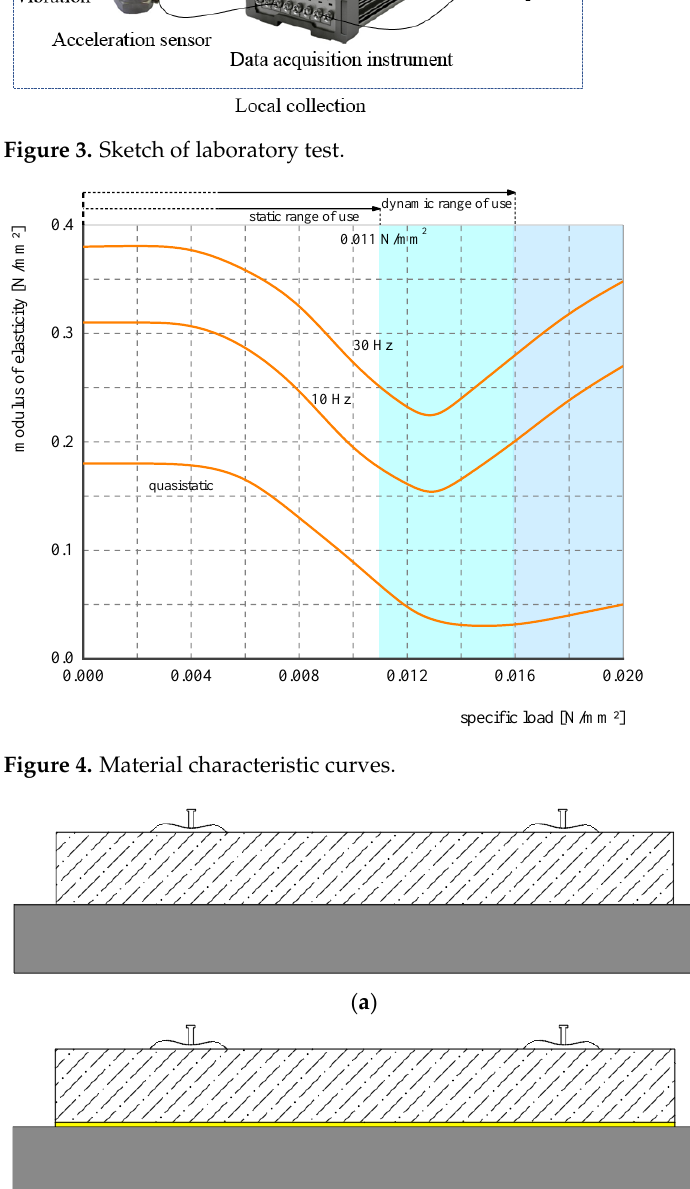
Figure 3. Sketch of laboratory test.